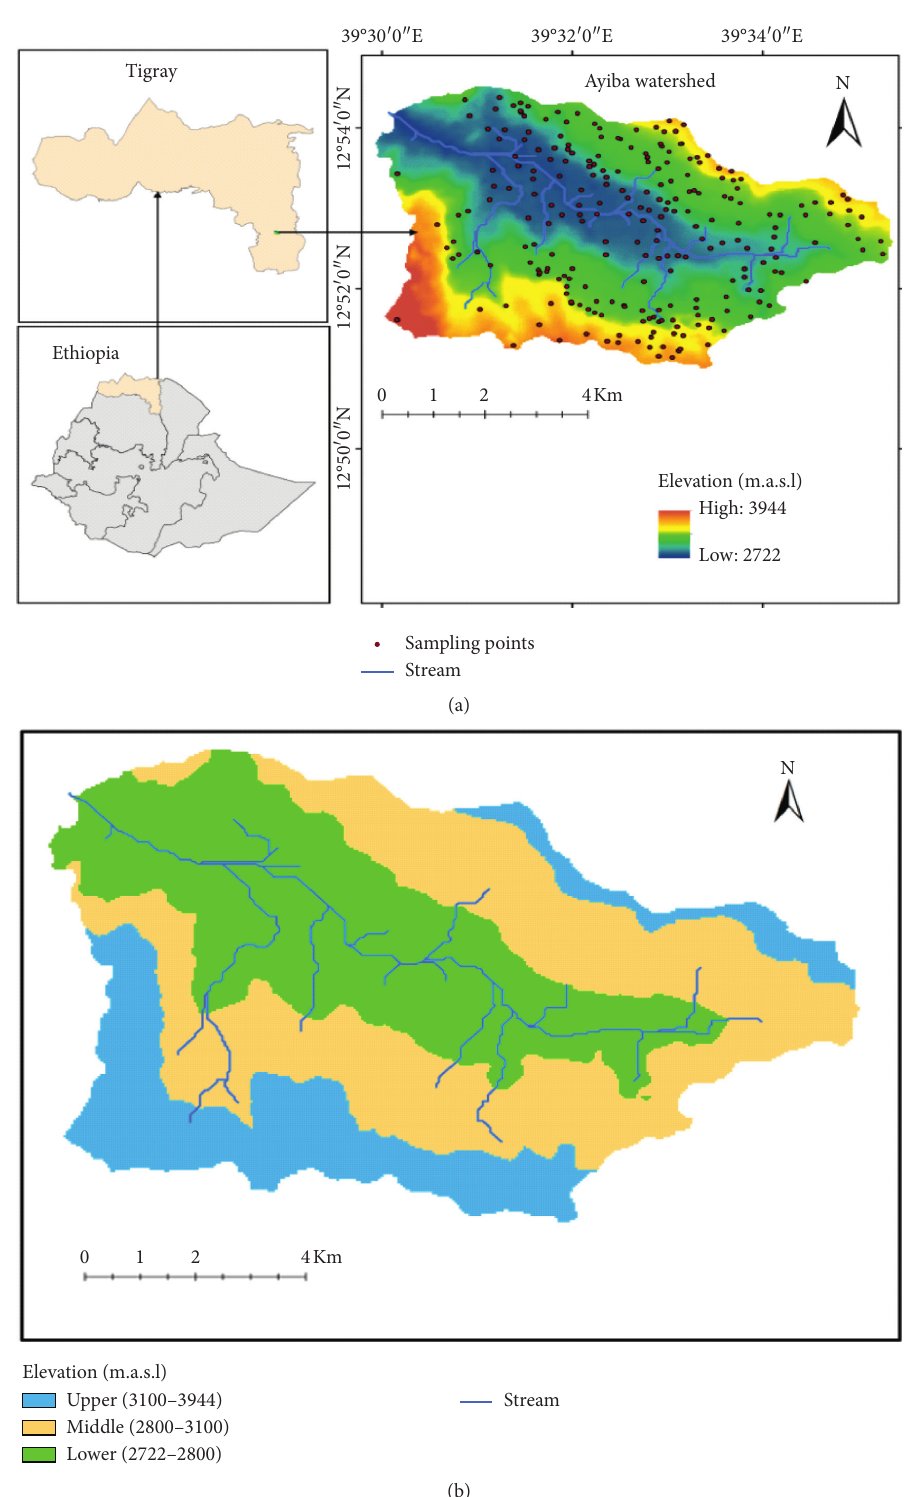
Figure 1: Map of the study watershed showing (a) the location and distribution of soil sampling points and (b) topographic